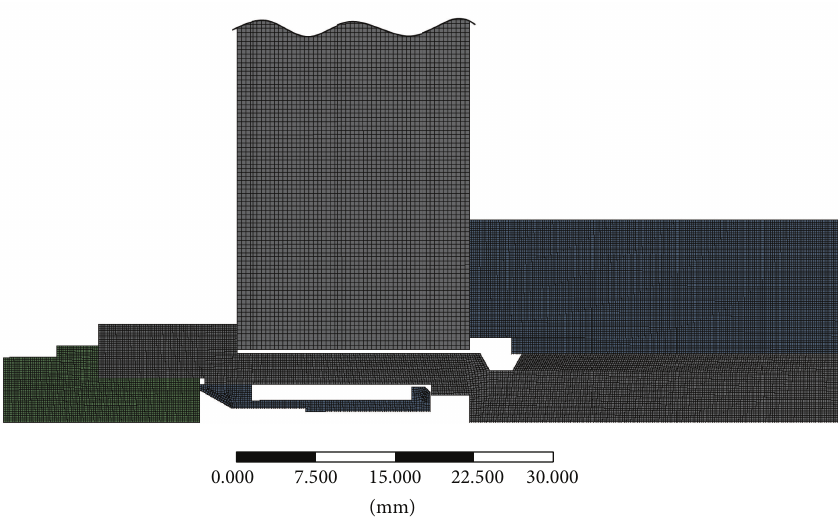
Figure 8: Meshing of the ridge-cut explosive bolts and the 22 mm thickness circular plate.